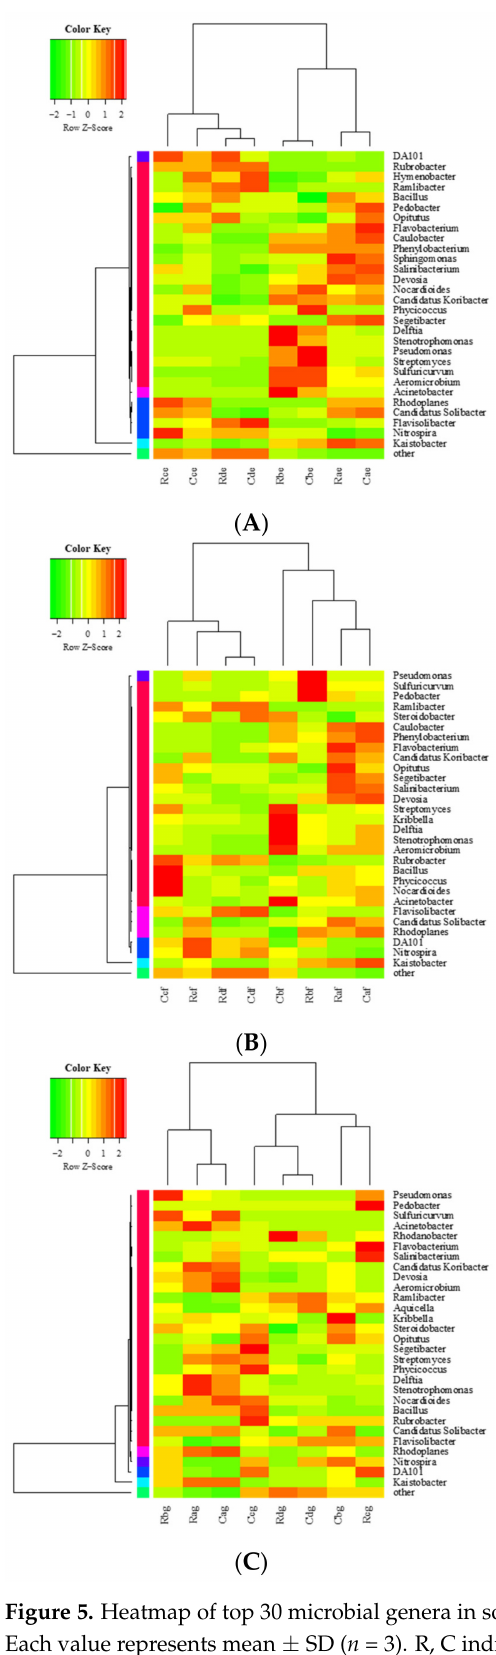
Figure 5. Heatmap of top 30 microbial genera in soil layers. ( A ) 0–10 cm, ( B ) 10–20 cm, ( C ) 20–30 cm. Each value represents mean ± SD ( n = 3). R, C indicate atrazine at recommended dose in AT and CK, respectively; a, b, c, d indicate soil samples at 1, 7, 21, and 119 d, respectively; e, f, g indicate 0–10, 10–20, and 20–30 cm soil levels,